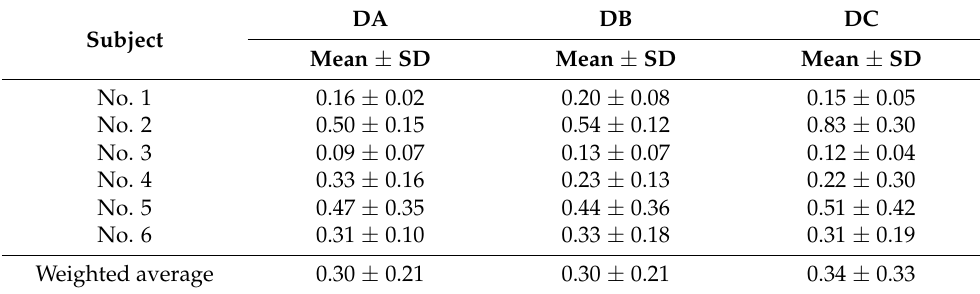
Table 1. Results of the measurements for each subject.